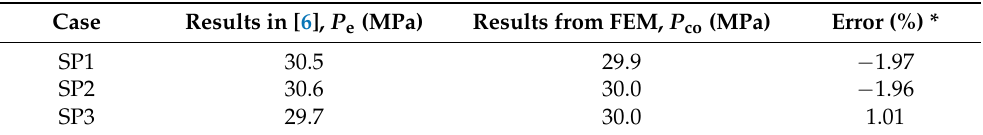
Table 2. Comparison of FEM calculation and experiment results from [6].